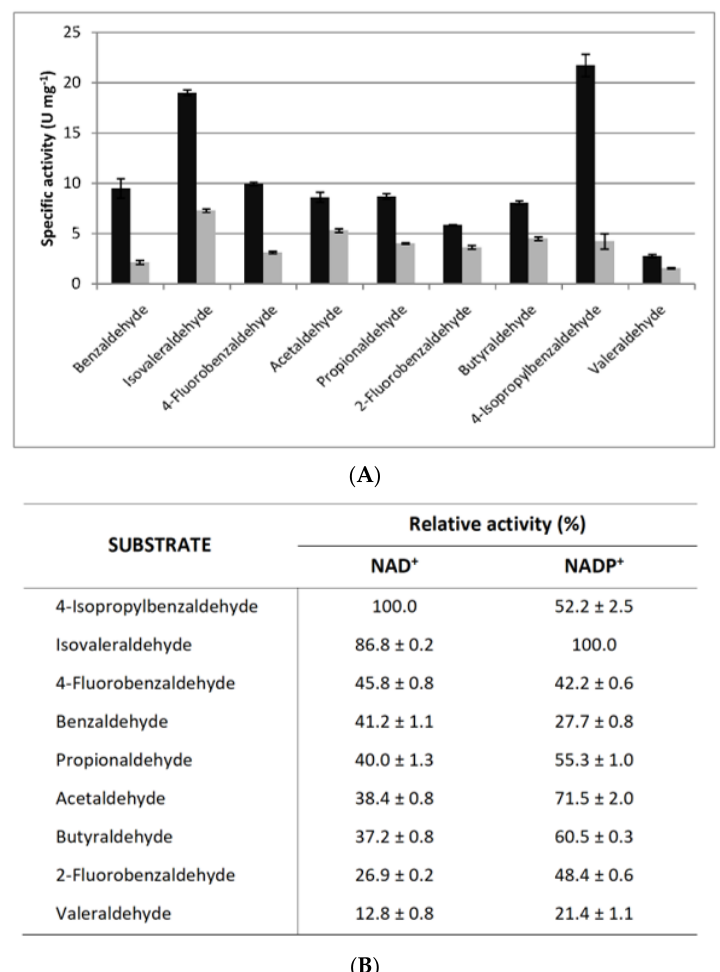
Figure 4. Substrate specificity of F-ALDH. ( A ) The specific activity of F-ALDH was measured at 25 ◦ C as indicated in Methods, using 1 mM aliphatic aldehydes (isovaleraldehyde, acetaldehyde, propionaldehyde, butyraldehyde, valeraldehyde) and aromatic aldehydes (benzaldehyde, 4-fluorobenzaldehyde, 2-fluorobenzaldehyde, or 4-isopropylbenzaldehyde) as substrates, in the presence of 1 mM NAD + and 1 mM NADP + . ( B ) Relative activity (%) was calculated considering 100% when using 4- isopropylbenzaldehyde (NAD + ) and isovaleraldehyde (NADP + ), respectively. The influence of metal ions and various additives on the NAD-dependent activity showed an overall stable response when using benzaldehyde as a substrate (Table 2). A moderate activity loss (18–22%) was observed in the presence of the protease inhibitor. Meanwhile, the addition of 10% ethanol or betamercaptoethanol ( β -ME) induced a slight activation up to 144.7% and 124.1%, respectively (Table 2).